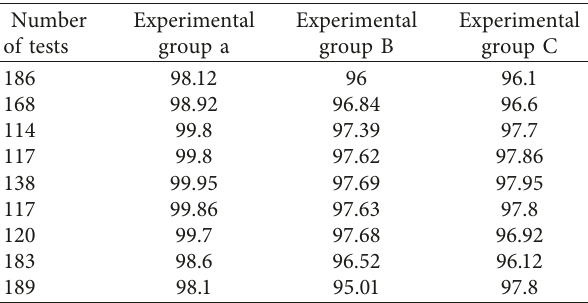
Table 2: Image recognition accuracy rate.